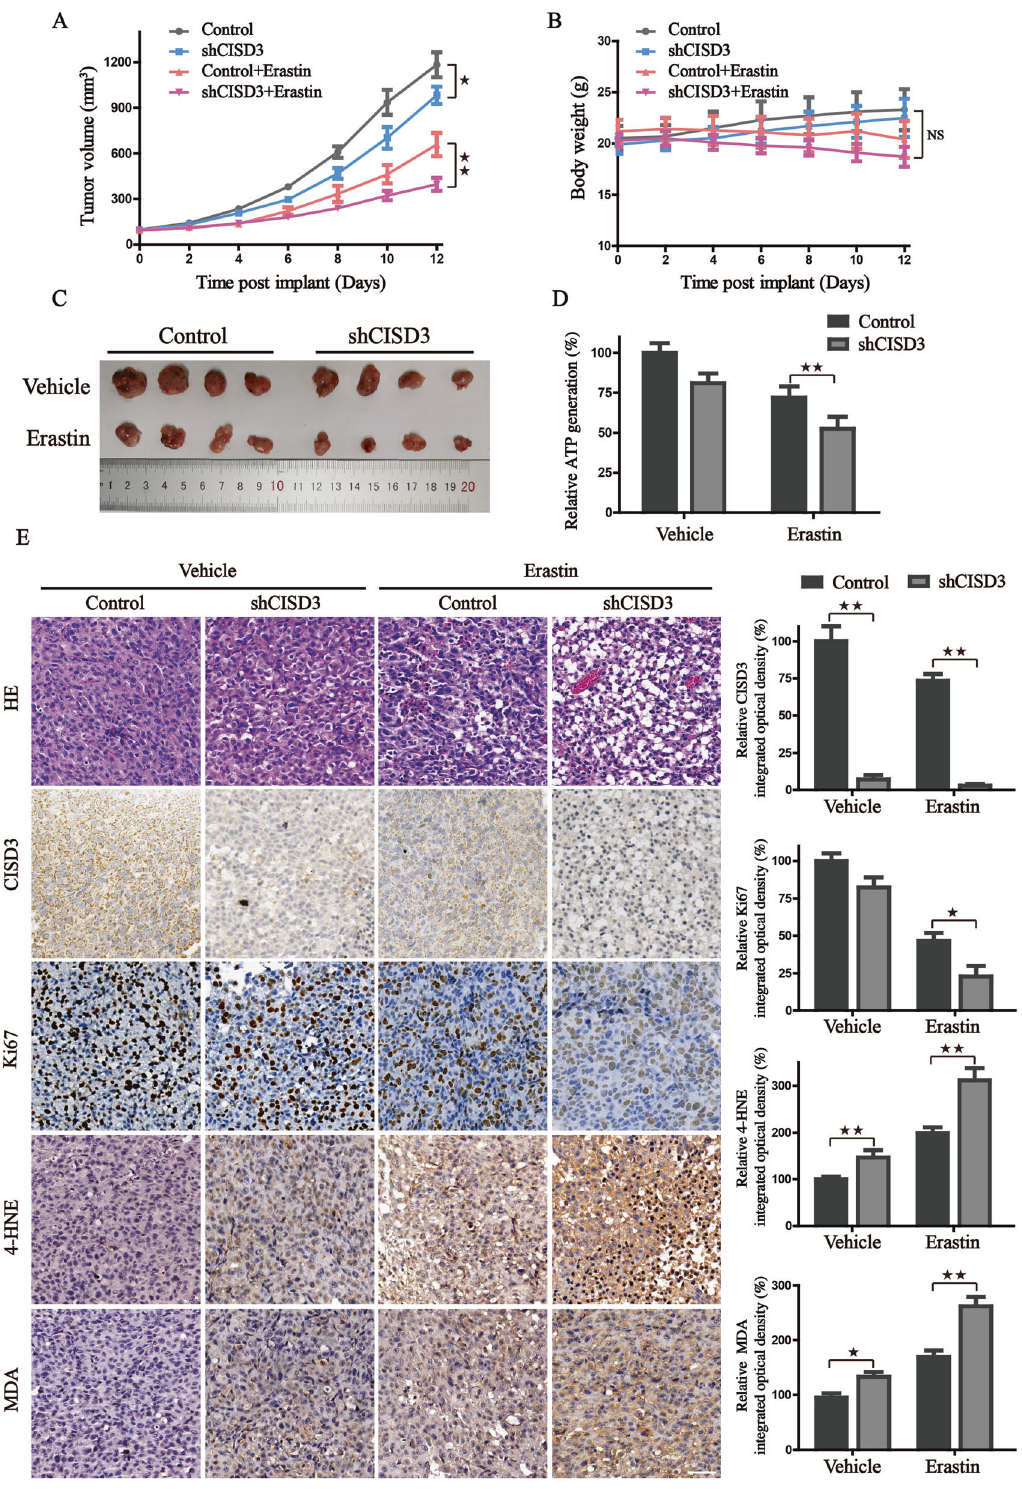
Fig. 8 CISD3 knockdown inhibits in vivo growth of xenograft. A The growth curves representing the average size of xenografts in mice harboring HT1080 cells with altered CISD3 expression in the presence or absence of erastin administration. Tumor volume was monitored every two days and calculated using the formula: 0.5 × a × b 2 . B The body weight curves of mice in indicated groups. NS indicates no statistical signi fi cance. C The morphological images of dissected xenografts in indicated groups. D Xenografts in each group were lysed and the ATP content was analyzed. E H&E staining and IHC analysis for CISD3, Ki-67, 4HNE, and MDA in indicated tumor tissues. Representative images were showed and the statistical columns were quanti fi ed via relative integrated optical density (IOD) value and showed on the right. * P < 0.05, ** P < 0.01 between indicated